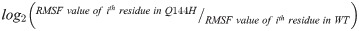
MD simulation analysis of the Q144H and WT CYP1B1 structures.Panel A shows marginally similar distributions of the first three major principal components of the Q144H and wild type (WT) CYP1B1 structures. Panel B shows that the Q144H mutant possesses a significantly altered flexibility pattern within the B-C, F-G and H block regions. The log2 ratio is calculated as log2(RMSF value of ith residue in Q144HRMSF value of ith residue in WT). Therefore, a positive value indicates an increase in flexibility in the Q144H mutant and a negative value indicates a decrease in flexibility as compared to WT CYP1B1. The significantly altered flexible regions are shown separately in the right hand side of the panel. Panel C shows the altered tunnels in two different orientations (top and bottom view) of the Q144H and WT CYP1B1 structures. Interestingly no tunnel was observed in the top orientation of the Q144H structure. The upper panel of "Tunnel properties" shows the radius (in bar plot) and length (in black line) of the tunnels (Top view orientation) in the mutant (pink) and WT (green) structures. The lower panel shows similar properties of tunnels observed in the bottom view orientation. Panel D shows docked retinol in the WT and mutant CYP1B1 structures. The panel also shows an overall decrease in binding energy in retinol binding for the mutant protein, observed through MD simulation.